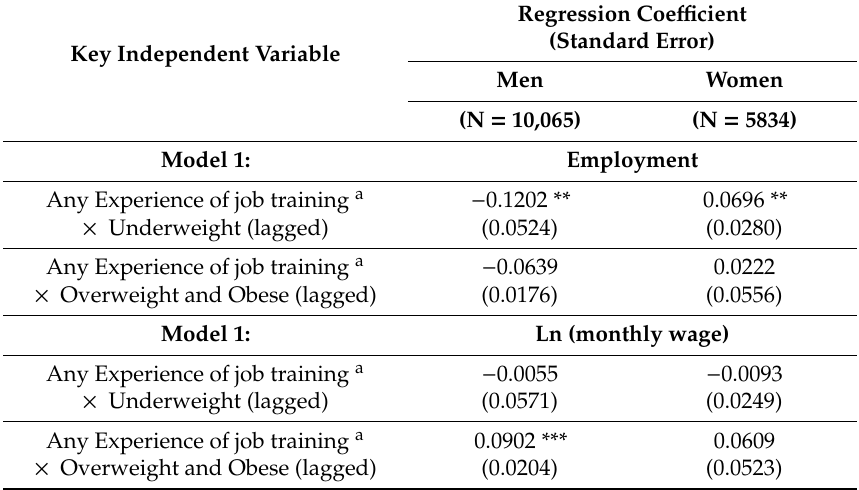
Table 5. Changes in the incremental e ff ect of BMI group on labor market outcomes by job training e ff orts.